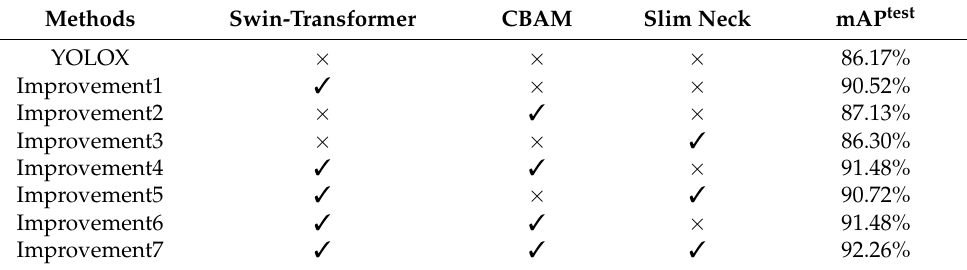
Table 3. Comparison of mAP for ablation